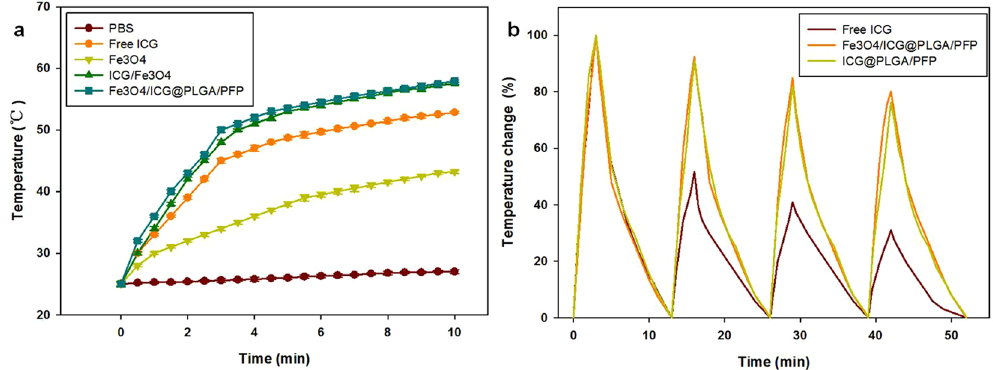
Figure 3. In vitro photothermal effects of Fe 3 O 4 /ICG@PLGA/PFP NPs. ( a ) Temperatures elevation of Fe 3 O 4 / ICG@PLGA/PFP NPs, mixture of free ICG and Fe 3 O 4 NPs, free ICG, Fe 3 O 4 NPs, and PBS with continuous NIR laser irradiation (808 nm, 1.0 W/cm 2 , 10 min). ( b ) Temperature changes of Fe 3 O 4 /ICG@PLGA/PFP NPs, ICG@ PLGA/PFP NPs, and free ICG over four NIR laser ON/OFF cycles.